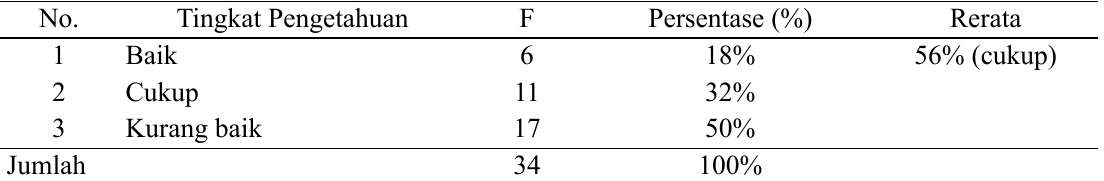
Tabel 1. Distribusi frekuensi pengetahuan (tahu) lansia tentang nutrisi di Posyandu lansia No.